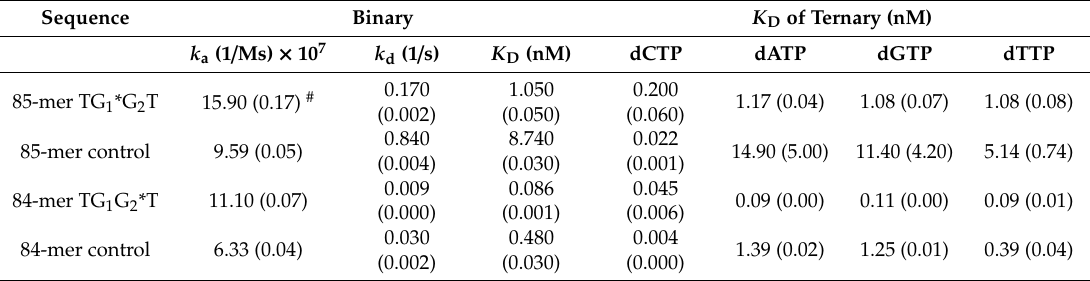
SPR binding a ffi nities, K D (nM) of unmodified (TG 1 G 2 T) and FABP − dG